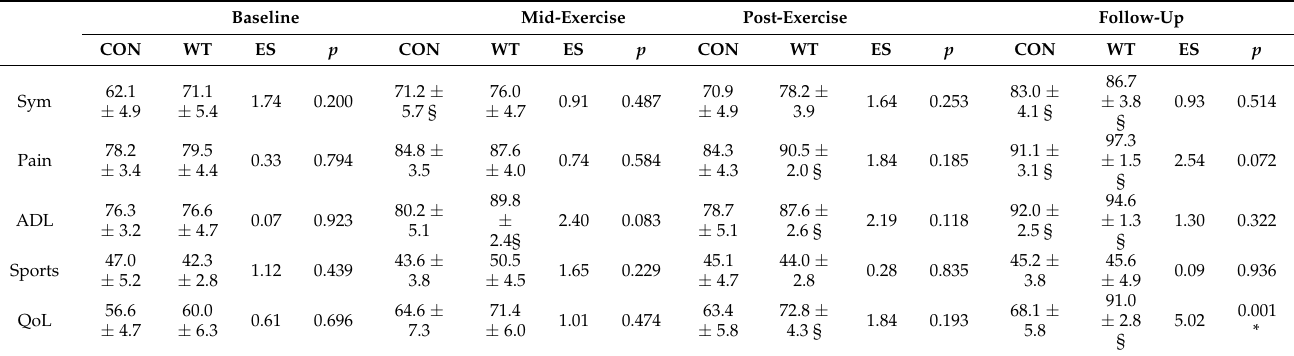
Table 6. Comparison of Knee Injury and Osteoarthritis Outcome Score (KOOS) subscales between two groups of TKA patients.